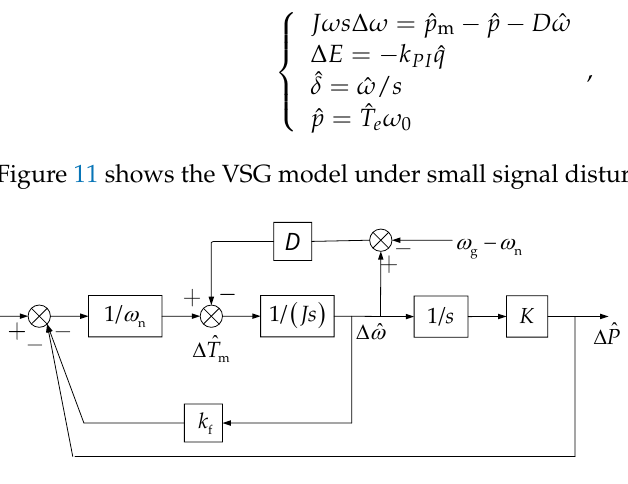
Figure 11. VSG small signal analysis model under disturbance.